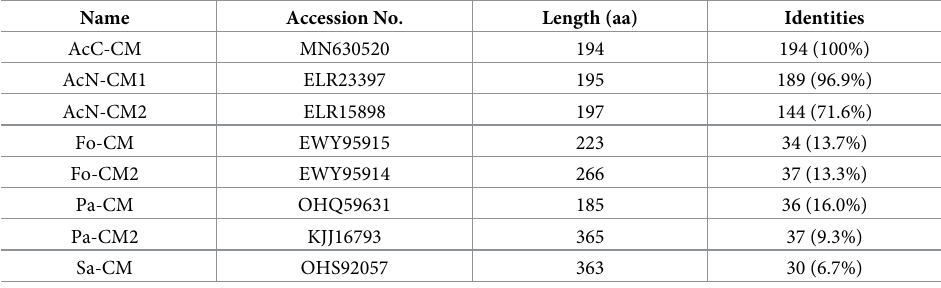
Table 1. Identities of chorismate mutase amino acids as determined by protein BLAST.